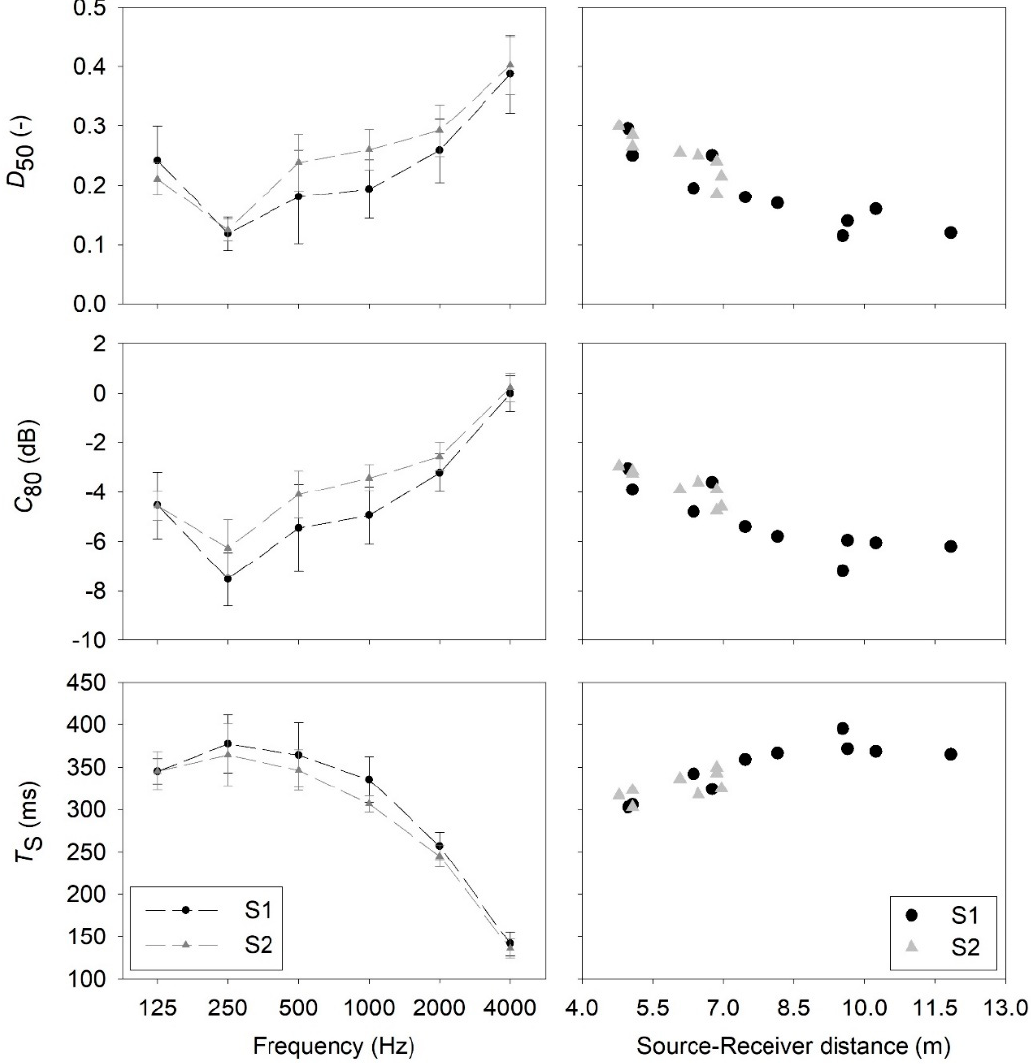
Figure 8. Spatially averaged values of the acoustic parameters as a function of frequency (left column)., and mid values as a function of source-receiver distance (right column).